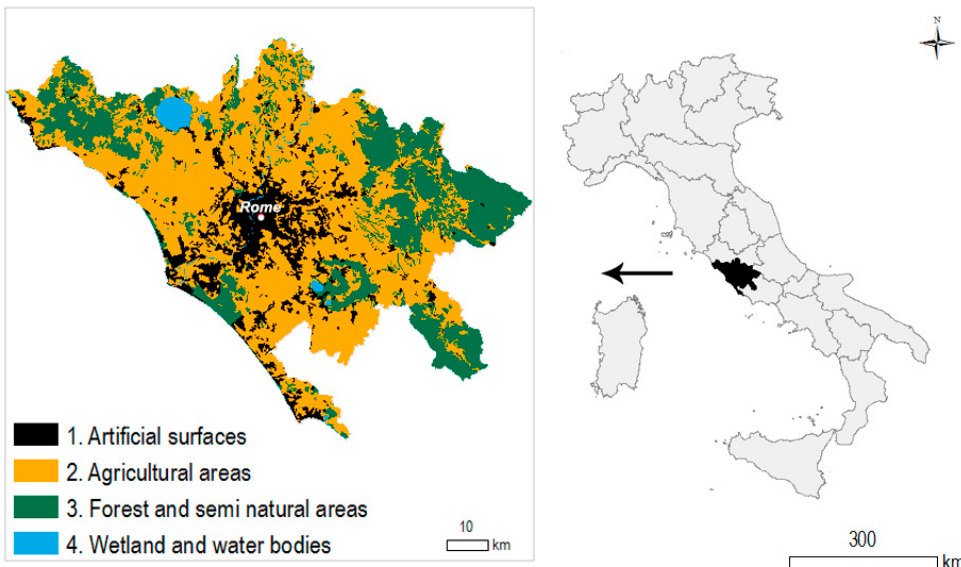
Figure 1. Location of the study area (right) and macro land-cover classes (left) in 2018: artificial surface (black), agricultural areas (orange), forest and semi-natural areas (green), and wetland and water bodies (blue). See Figure B1 in Appendix B for further information.